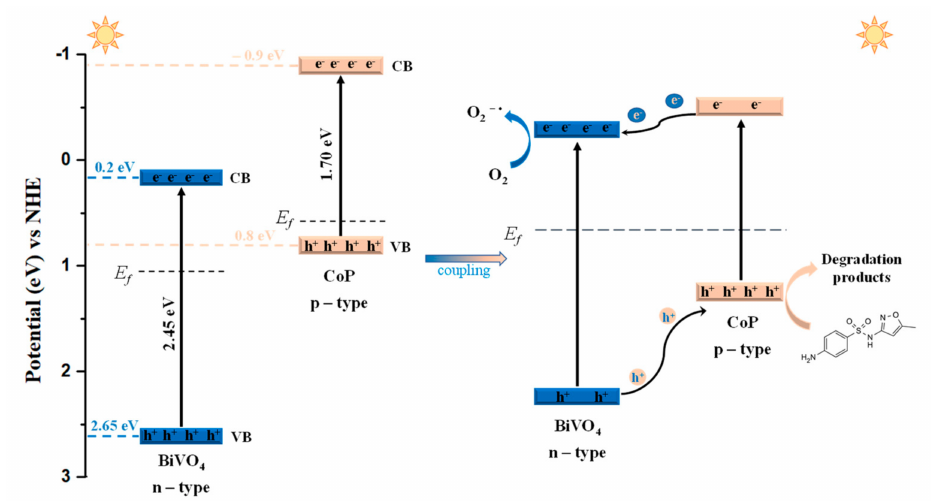
Scheme 1. Simplified diagram showing the relative band edge positions and charge separation at CoP/BiVO 4 photocatalyst under irradiation.